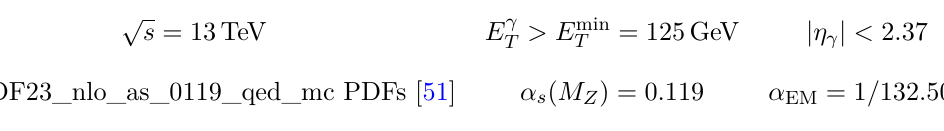
Table 1 . Kinematics and input parameters used for the cross section computations in this paper. For our fixed-order computations in section 3 we use the default scales µ a = µ f = µ r = 125 GeV , where µ r and µ f are the renormalization and factorization scales, respectively, and µ a is the scale associated with the non-perturbative fragmentation function. For the resummed results, we use